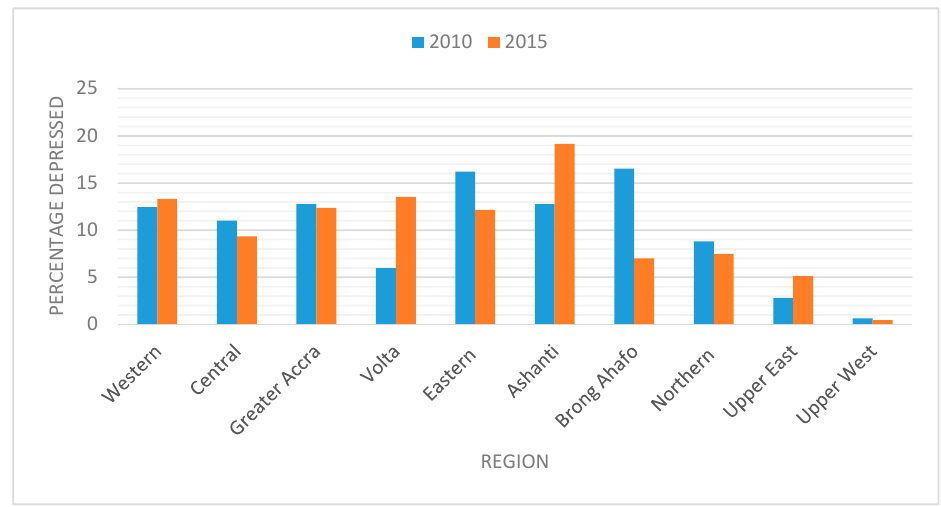
Figure 1. Percentage of depressed respondents between 2010 and 2015 by regions.